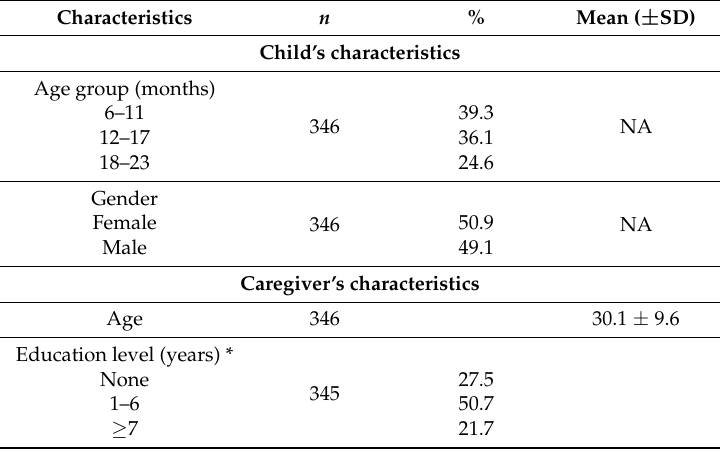
Table 2. Description of the population.